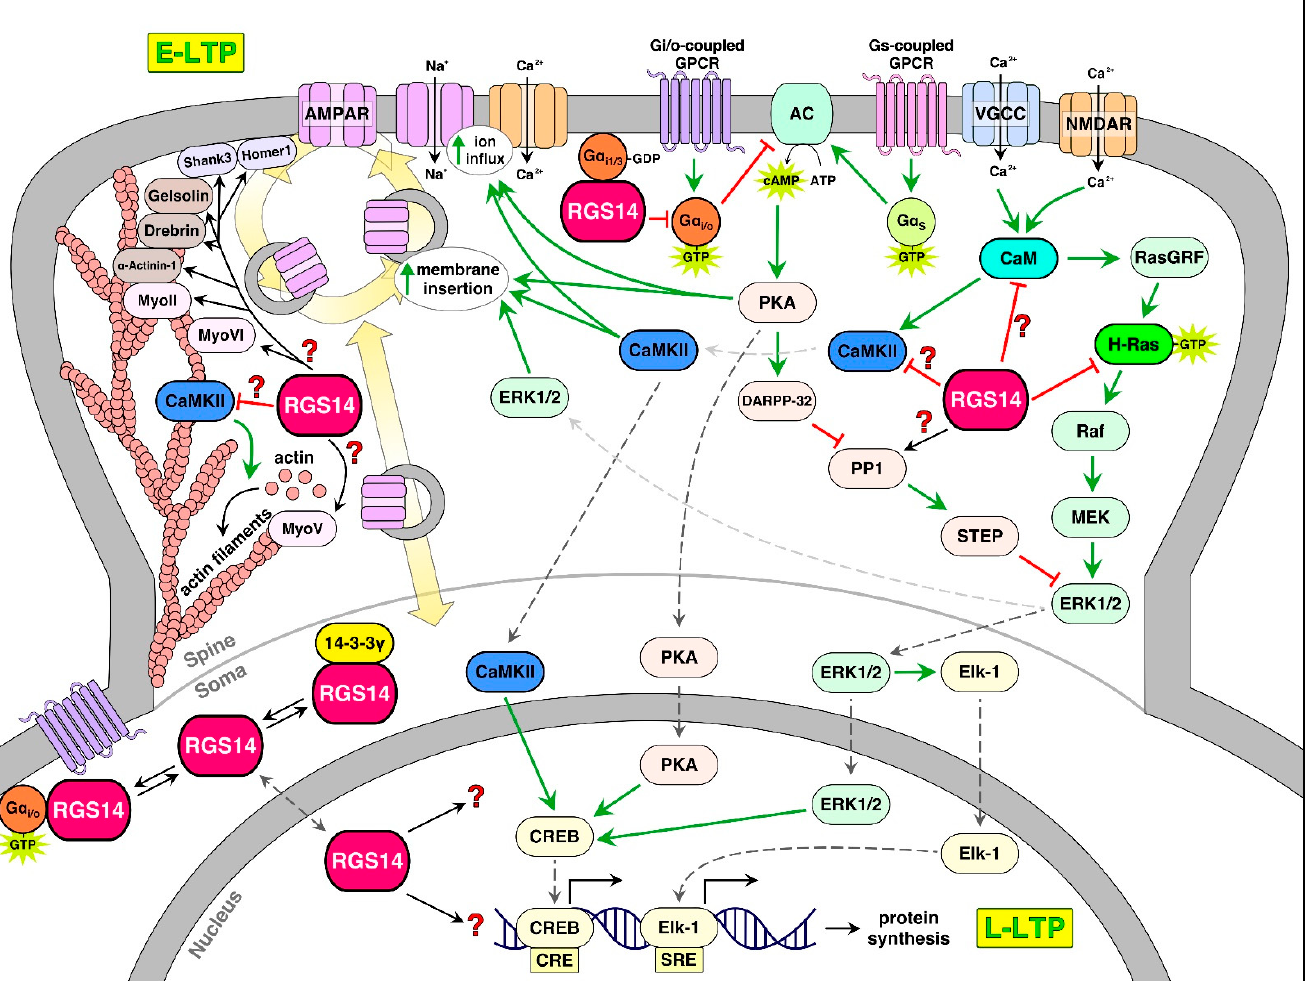
Figure 7. RGS14 modulation of postsynaptic signaling and plasticity. RGS14 binds many protein partners, directly or indirectly, to regulate signaling events and plasticity in the post synaptic dendritic spine (top) and in the soma where it shuttles in/out of the nucleus (bottom). Key: green line with arrow = activation (increase if inside bubble), red line with T arrow = inhibition, black line with arrow = interaction or relationship (unspecified directionality), dashed gray line = movement, question mark = unknown or uncertain interaction. This key is also used in Figures 3–6.